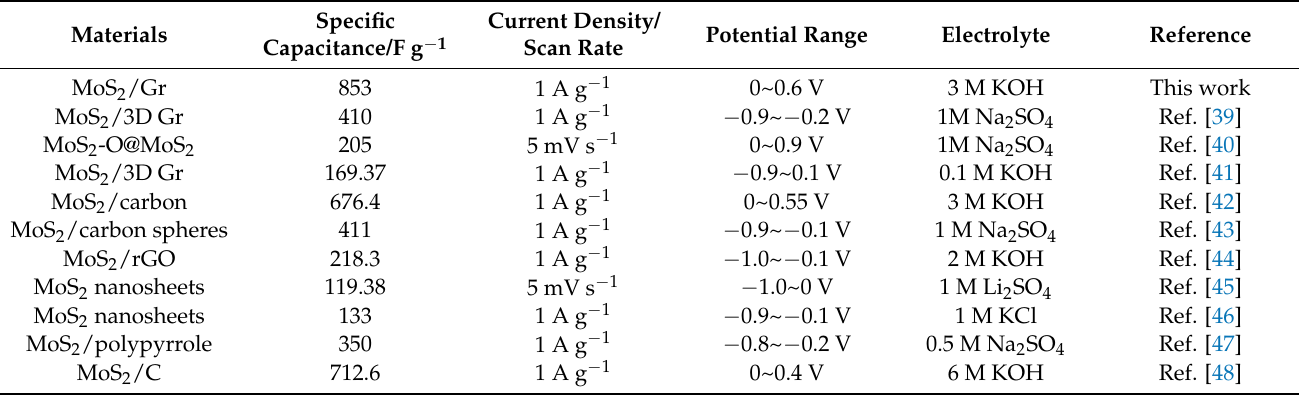
Table 1. Comparison of the specific capacitance of the electrode in this work compared with those based on MoS 2 /Gr hybrids reported in the literature.